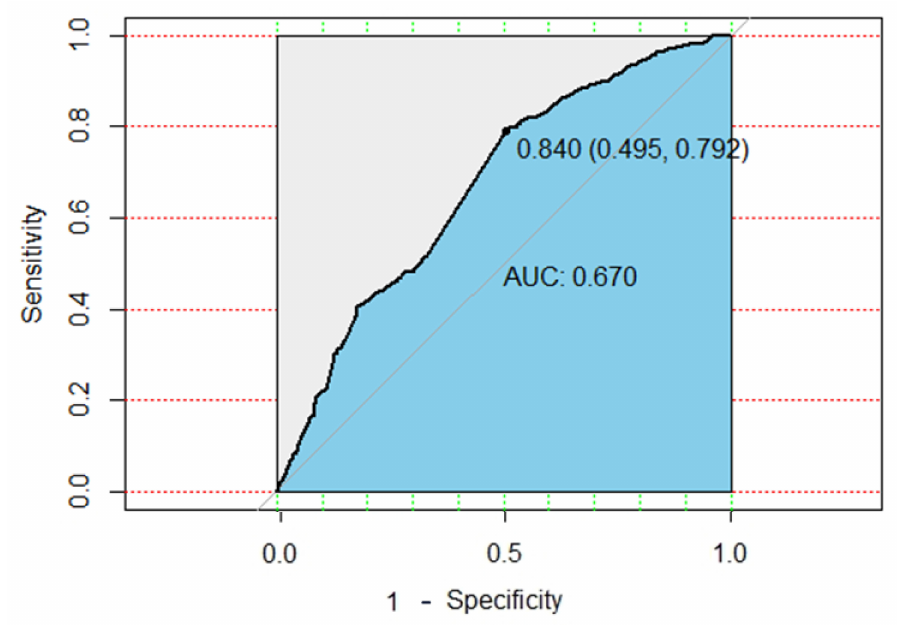
Figure 5. ROC plot of XGBoost